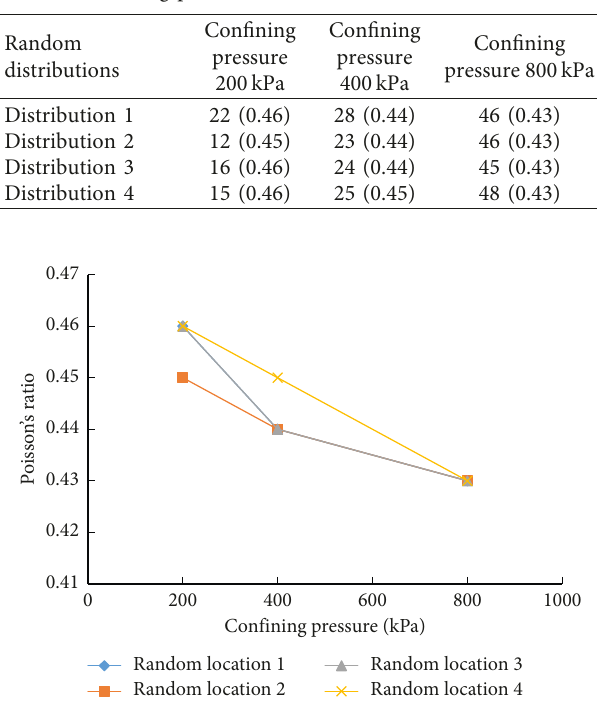
Figure 10: Rule of Poisson’s ratio under different